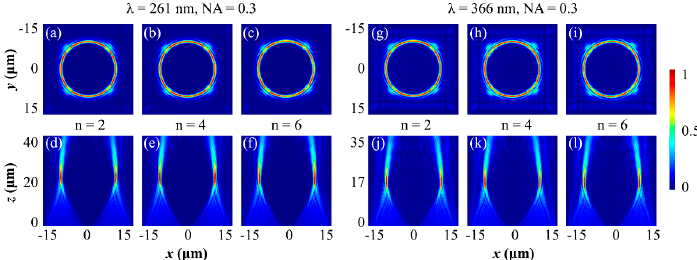
Figure 5. Numerically simulated behavior of the designed metasurfaces for other UV wavelengths. ( a – c ) and ( g – i ) presents the intensity distribution at the focal planes (XY planes) whereas ( d – f ) and ( j – l ) illustrates the results captured by the XZ monitors, placed along the propagation direction of the light. The designed metasurfaces are simulated for wavelengths 𝜆 = 261 and 366 nm and concluded that the proposed Si 3 N 4 -based metasurfaces are capable of tailoring the complete wavefront of the incident light of different UV wavelengths.